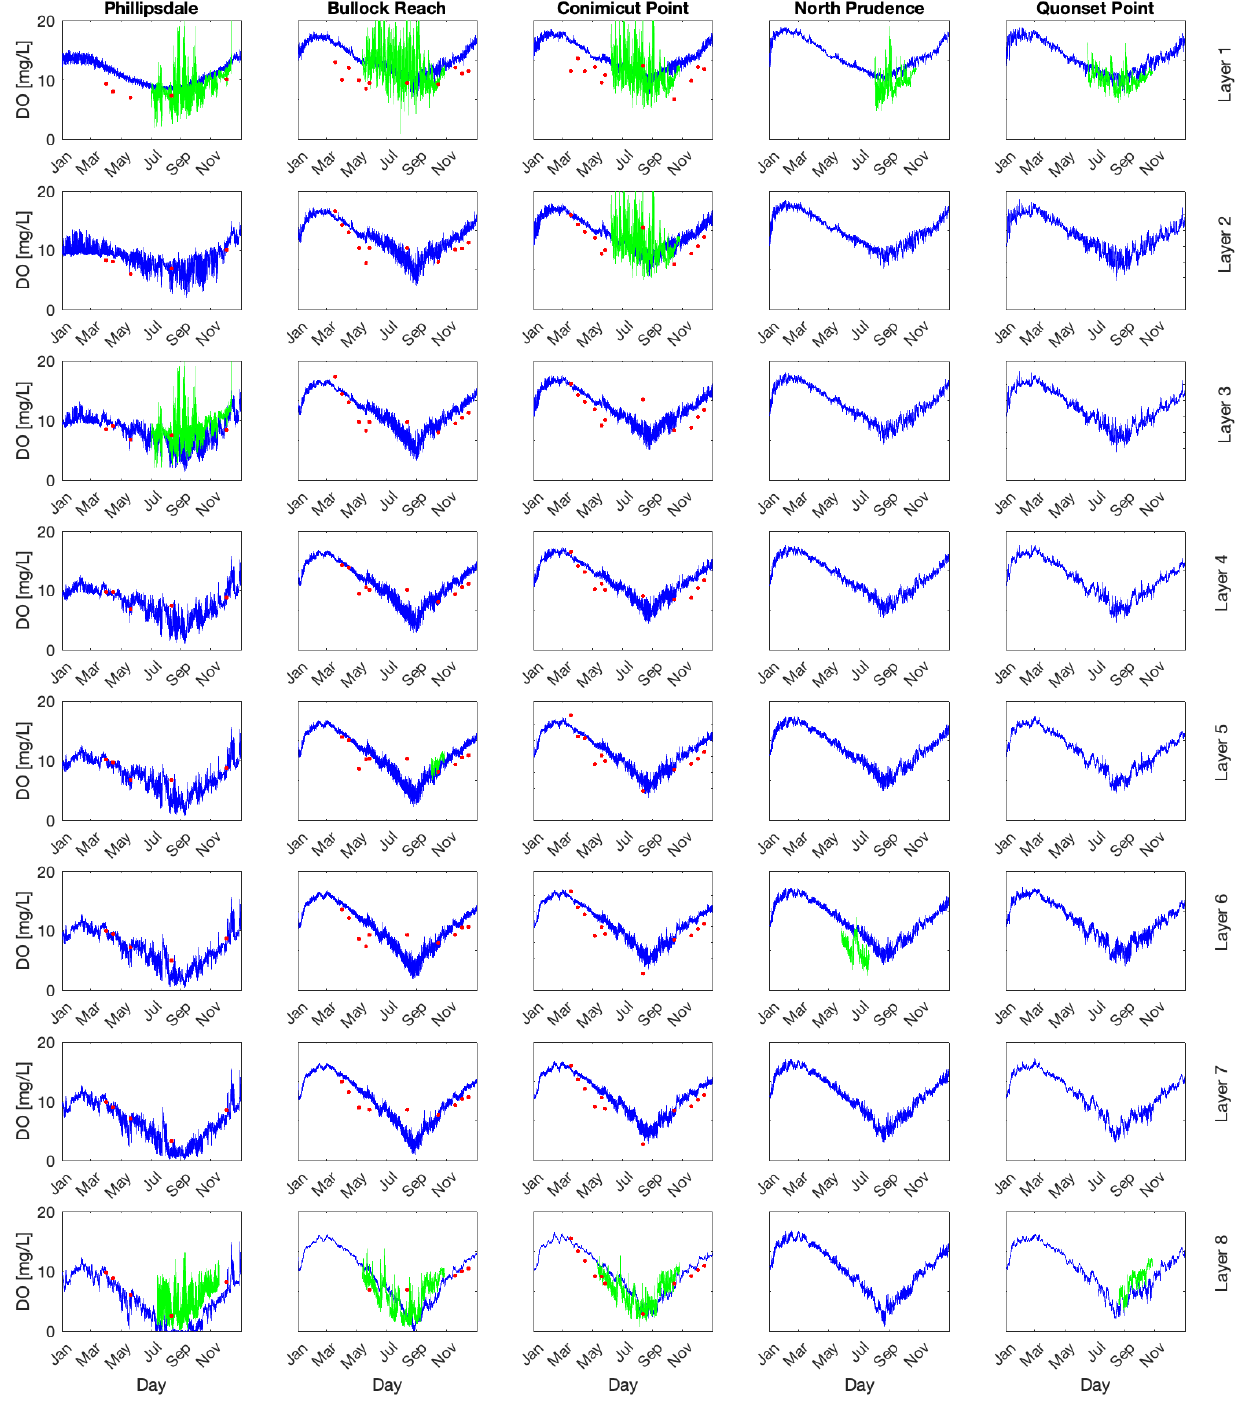
Figure 4. Dissolved Oxygen Concentrations [mg/L] in Narragansett Bay at 5 locations with depth. Each column represents where there is observed data, from north to south on the west side of the Bay. Each row represents a water column layer, from Layer 1 at the surface to Layer 8 right above the sediments. The solid blue lines represent the WASP simulated DO. The solid green lines are the observed sonde data (15 min intervals). The red dots are the depth profile samples, only available at the first three locations. The simulations of phytoplankton are shown in Figure 5 with the same layout of rows and columns and locations as Figure 4. Simulated [chl a ] is presented in blue, and the contin- uous (15 min) sonde observations in green. Depth profile observations were not available for